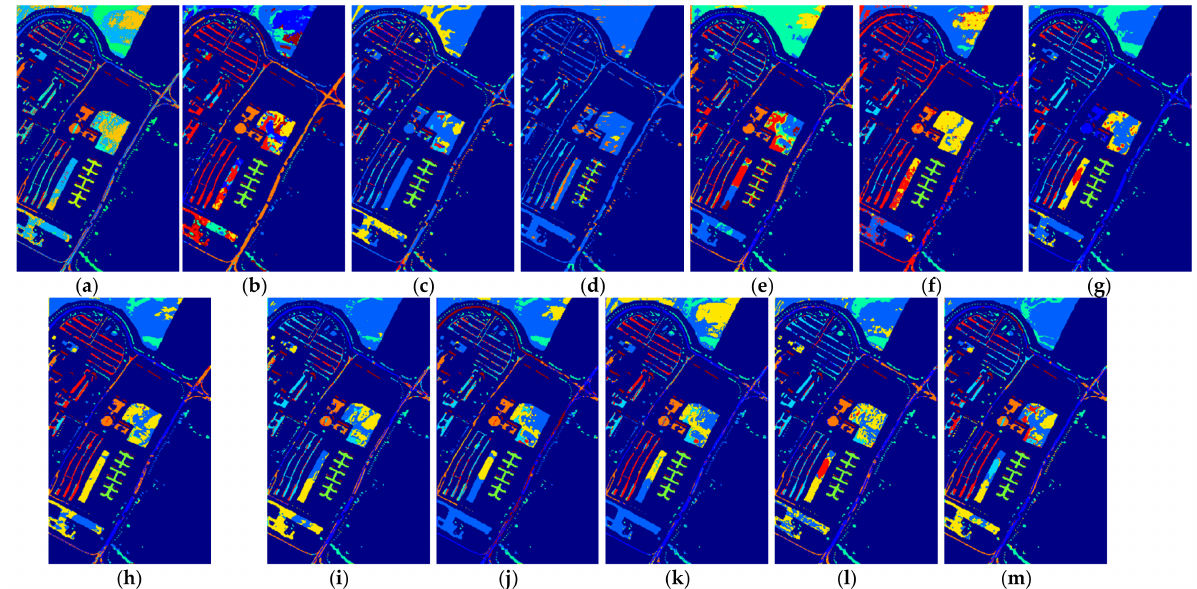
Figure 7. The classification maps of all methods with three samples on PaviaU dataset. ( a ) SVM; ( b ) SS-LapSVM; ( c ) 3D-DENSEnet; ( d ) 3D-Gan; ( e ) SS-CNN; ( f ) 3D-CNN; ( g ) 3D-CNN k - means ( h ) 3D-CNN ours ; ( i ) 3D-CNN hardlabel ; ( j ) SSRN; ( k ) SSRN k - means ; ( l ) SSRN ours ; ( m ) SSRN hardlabel